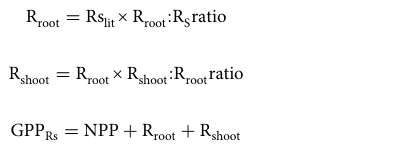
Fig. 1 and Eqs. 1 – 3) from the Rs lit estimates according to R root :R S ratio (RC), R root :R shoot ratio (data from both the SRDB and an additional literature search,